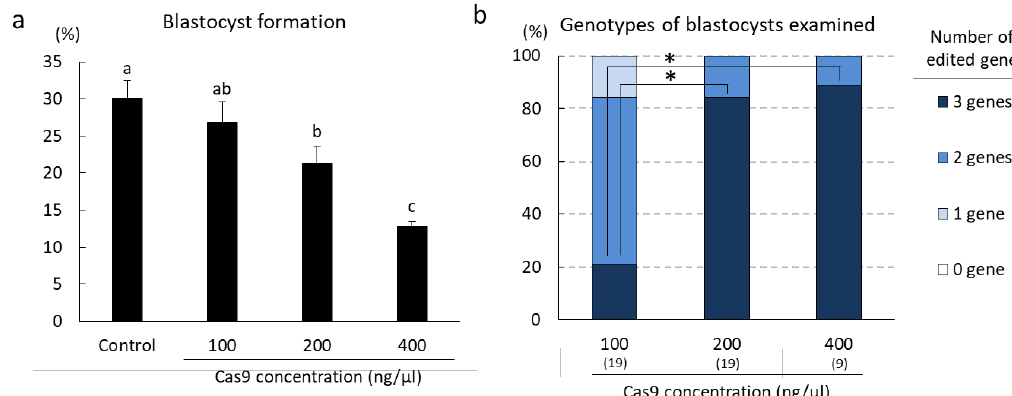
Figure 4. Optimization of conditions for gene editing targeting GGTA1 , CMAH, and B4GALNT2 . ( a ) Effects of the Cas9 concentration on the developmental competence of electroporated zygotes. For each treatment group, five replicates with 243–253 oocytes per treatment were analyzed. Means ± SEM are shown. a–c Values with different superscript letters differed significantly ( p < 0.05) and those sharing the same letter did not differ significantly. ( b ) Effects of the Cas9 concentration on gene editing efficiency. Genotypes of blastocysts were determined using TIDE. Numbers within parentheses indicate the total numbers of examined blastocysts. Percentages of blastocysts carrying mutations in GGTA1 , CMAH , and B4GALNT2 were analyzed using chi-squared tests. * p < 0.05.